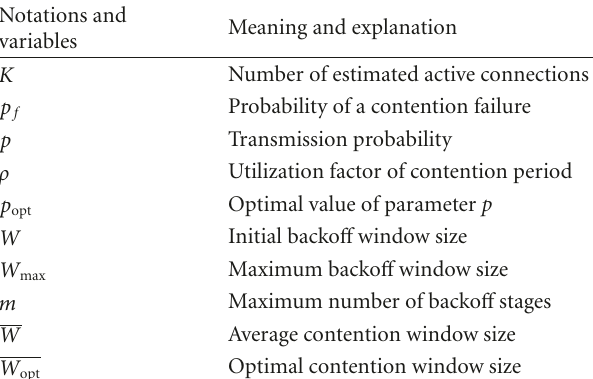
Table 1: Notations and variables used in analytical